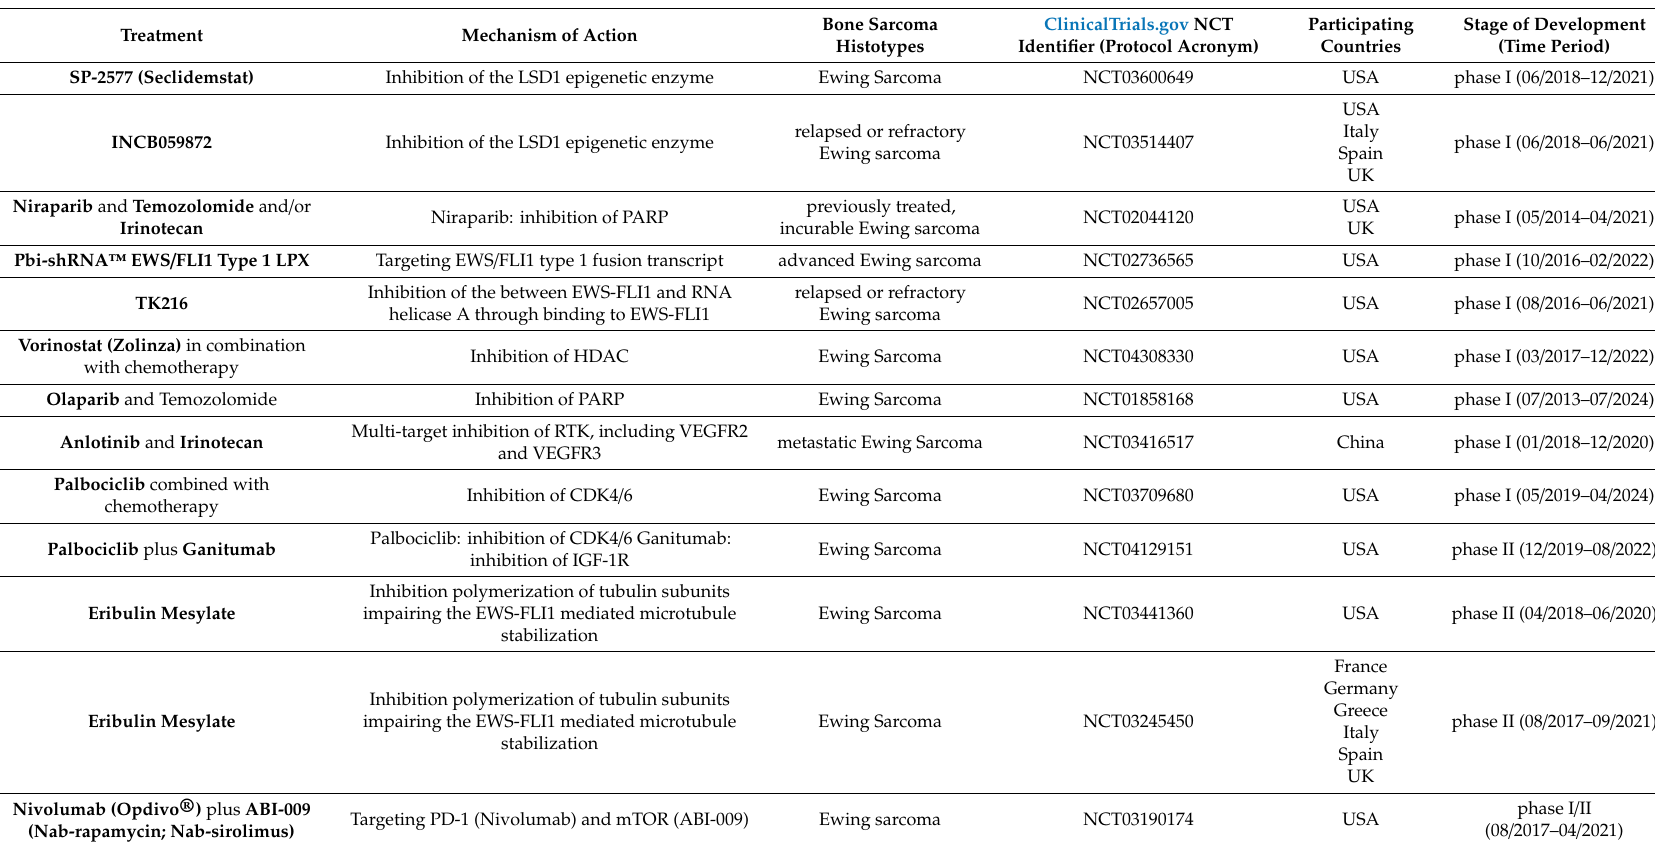
Table 3. List of target-specific clinical trials that are presently active and recruiting Ewing sarcoma patients. Trials that are also recruiting high-grade osteosarcoma or chondrosarcoma patients are listed in Tables 1 and 2. Time period refers to the actual study start date and estimated study completion